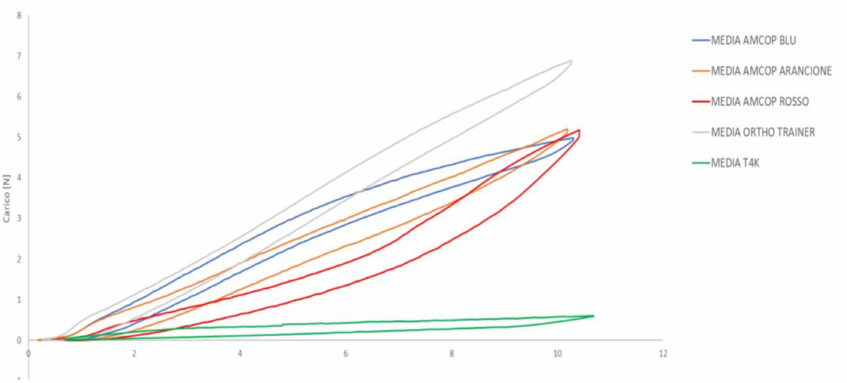
Figure 5. Average compression and release curves of the devices. X -axis represents the displacement expressed in millimeters; Y -axis shows the applied load, expressed in N.